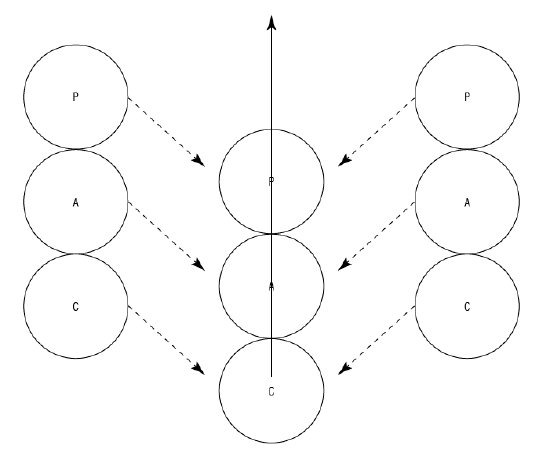
Figure 3: Script Matrix (Hay, 2012, p.18)